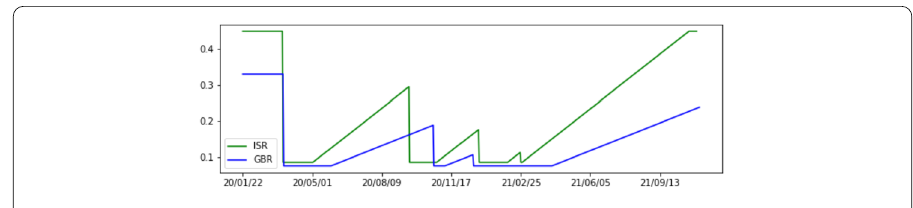
Figure 6 Evolution of p e over